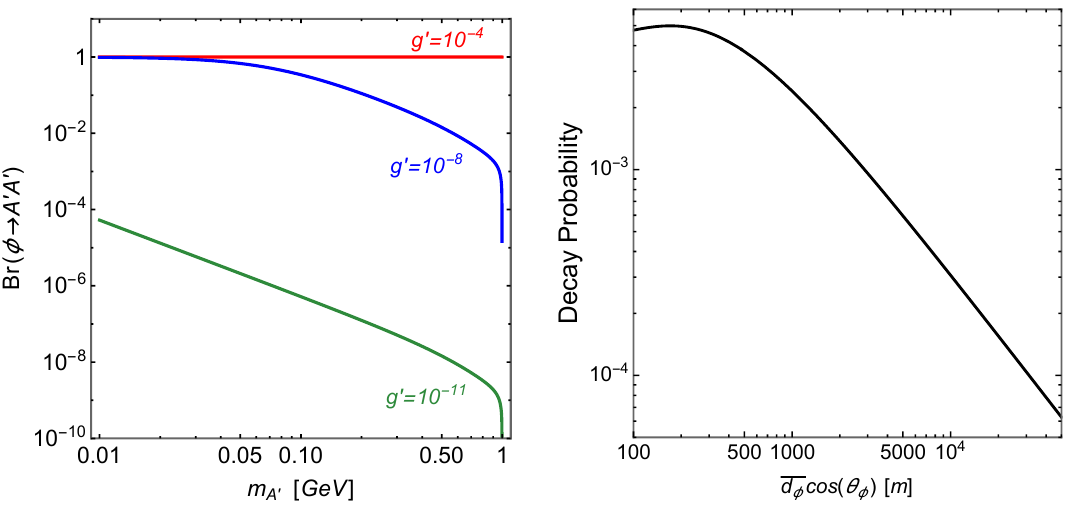
Figure 3 . Left: the branching ratio of φ → A 0 A 0 as a function of m A 0 for m φ = 2 GeV. The red, blue, and green curves correspond to g 0 = 10 − 4 , 10 − 8 , and 10 − 11 , respectively. Right: the decay probability, (4.6), as a function of the decay length ¯ d φ cos θ φ with g 0 = 10 − 8 at FASER 2.